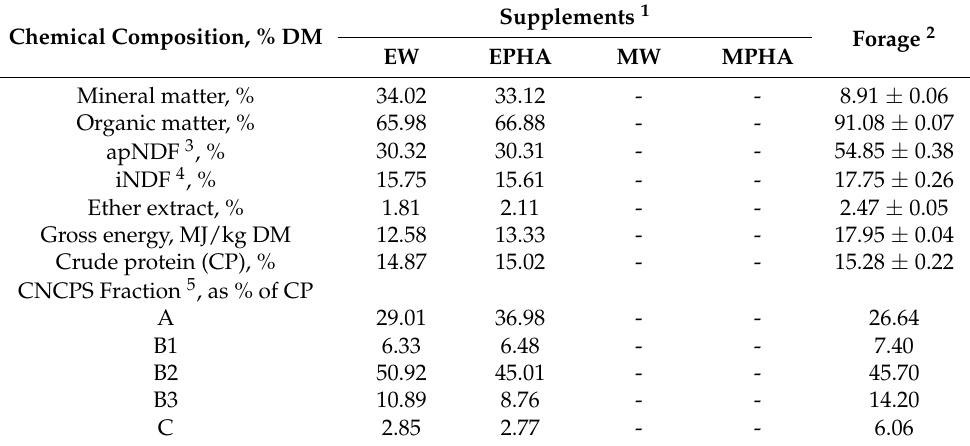
Table 1. Chemical composition of forage ( Urochloa brizantha cv. Marandu) and energy